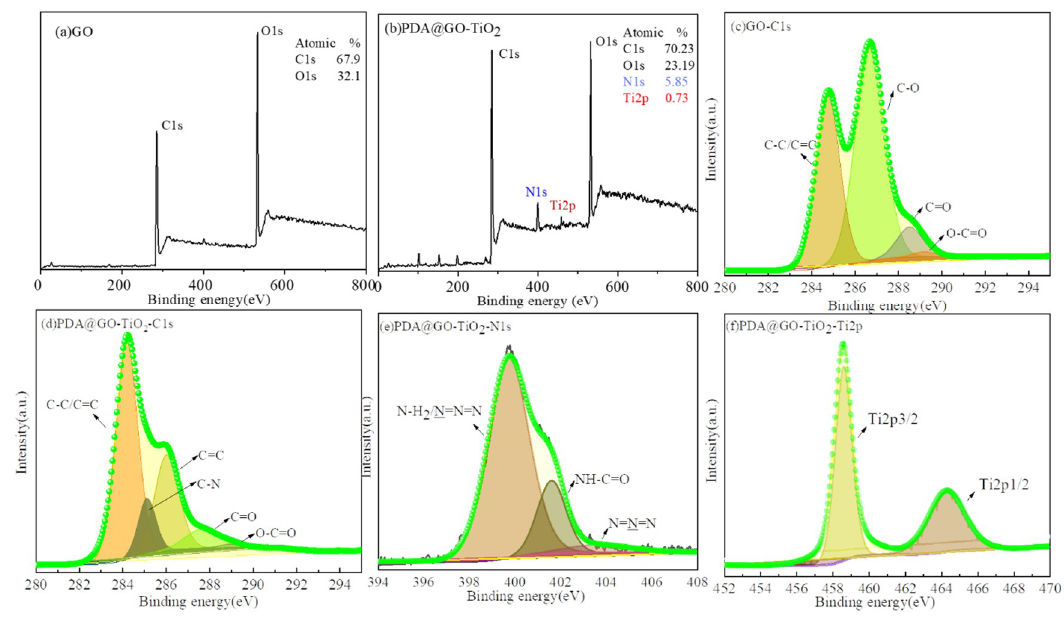
Figure 6. X-ray photoelectron spectroscopy (XPS) spectra of ( a ) GO, ( b ) PDA@GO-TiO 2 , ( c ) GO/C1s, ( d ) PDA@GO-TiO 2 / C1s, ( e ) PDA@GO-TiO 2 / N1s, and ( f ) PDA@GO-TiO 2 / ( d ) PDA@GO-TiO 2 /C1s, ( e ) PDA@GO-TiO 2 /N1s, and ( f ) PDA@GO-TiO 2 /Ti2p.